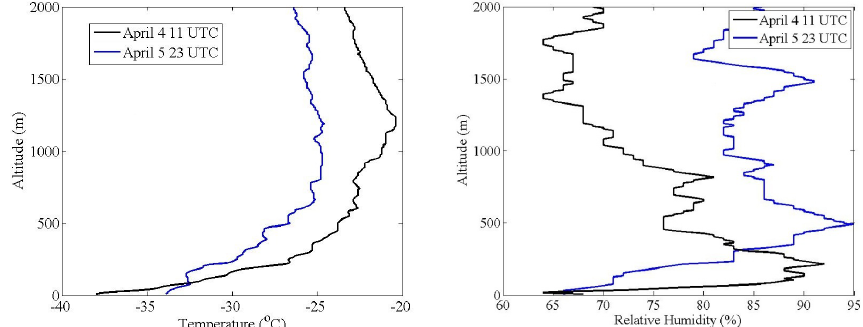
Fig. 12. Radiosonde air temperature (left panel) and relative humidity (right panel) profiles extending to 2000m for 11:00UTC, 4 April 2009 (black; clear-sky case), and 23:00UTC, 5 April 2009 (blue; ice crystal cloud